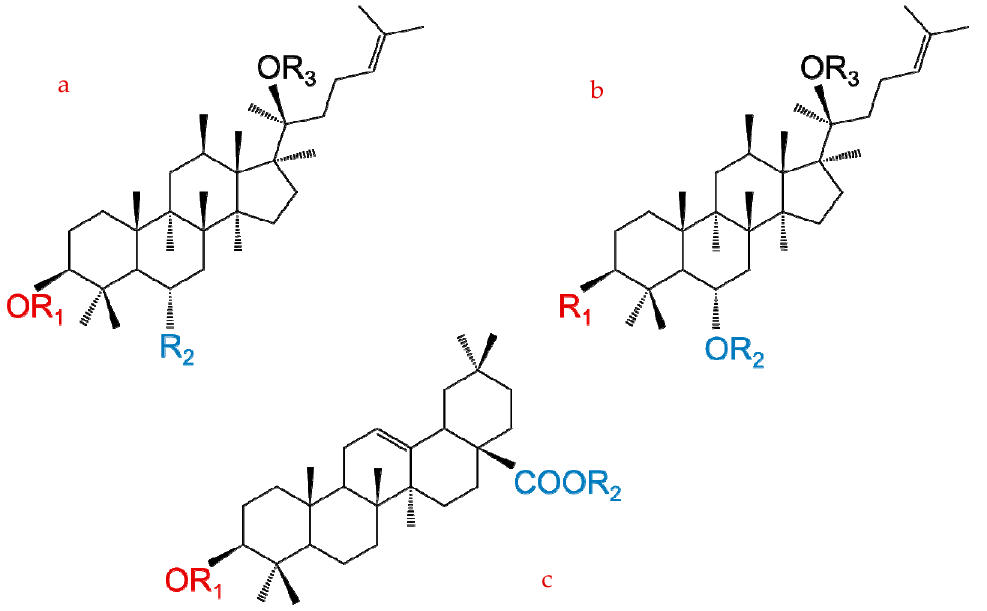
Figure 1. Chemical structures of three ginseng saponin types: ( a ) protopanaxadiol type (PPD); ( b ) protopanaxatriol type (PPT); and ( c ) oleanolic acid type.